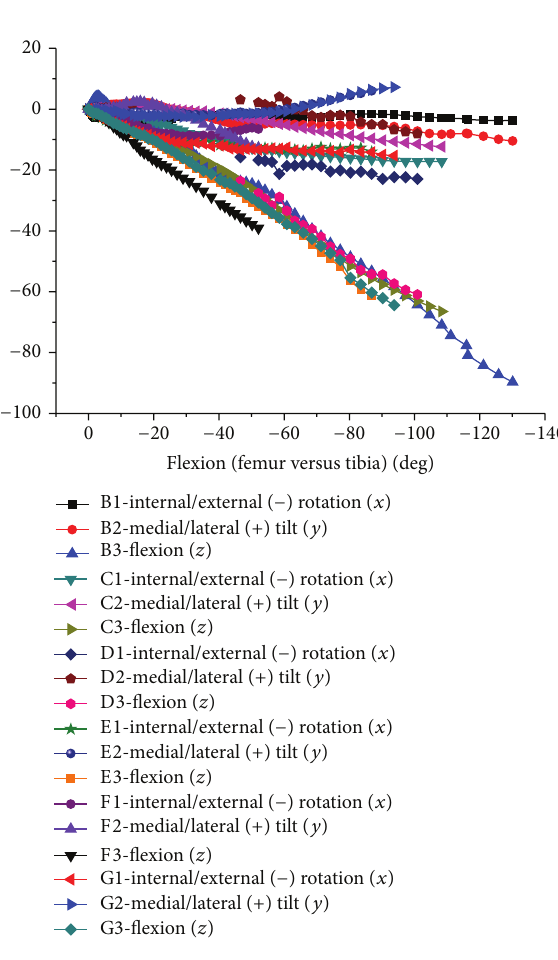
Figure 15: Internal/external, abduction/adduction, and flexion of patellofemoral joint relative movements in both test and FEA.